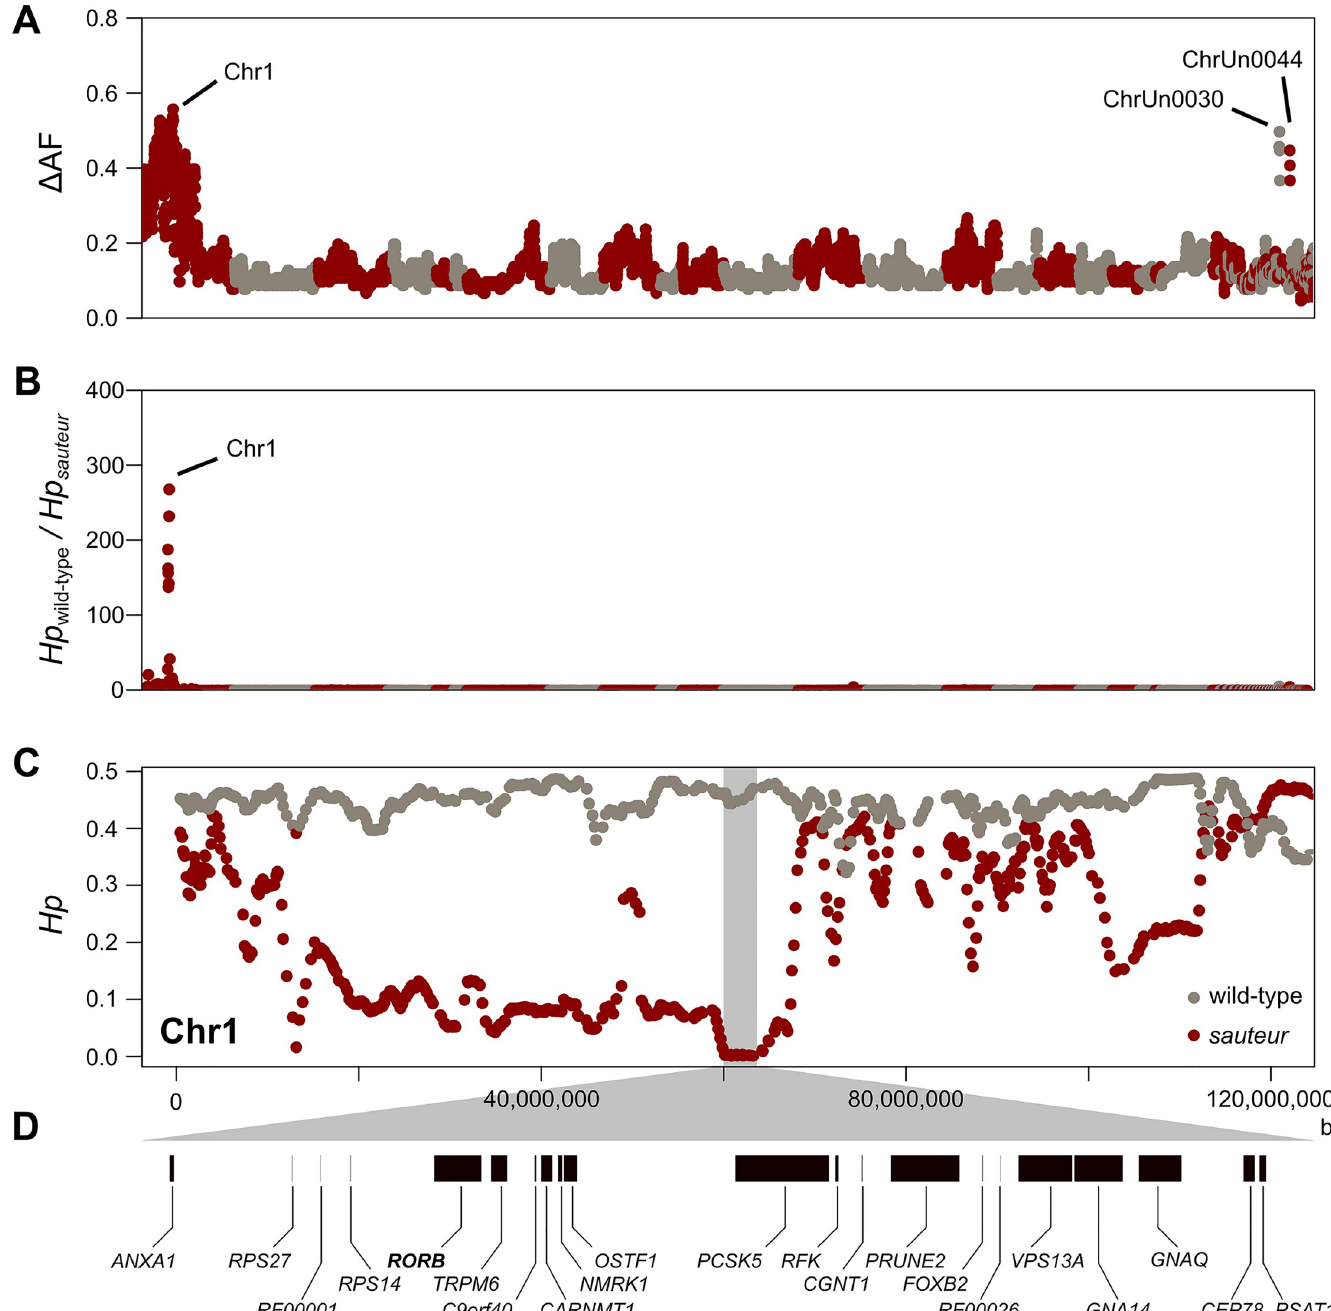
Fig 2. Genetic mapping of the sauteur allele using experimental crosses and whole-genome analyses. (A) Genetic differentiation ( Δ AF) between the sauteur and wild-type pools across the genome. Each dot represents Δ AF averaged in windows of 5,000 SNPs with 1,000 SNPs steps. All scaffolds of the reference genome containing at least one valid window are presented along the x-axis in alternate colors. (B) Ratio of pooled heterozygosity ( H ) in the sauteur pool by H in the wild-type pool across p p the genome. Each dot represents the ratio averaged in windows of 5,000 SNPs with 1,000 SNPs steps. All scaffolds of the reference genome containing at least one valid window are presented along the x-axis in alternate colors. (C) Close-up of H across a large portion of chromosome 1 represented separately for the sauteur pool (red p dots) and the wild-type pool (gray dots). The shaded area represents the candidate region where H p is extremely low in the sauteur pool. (D) Genes located within the candidate